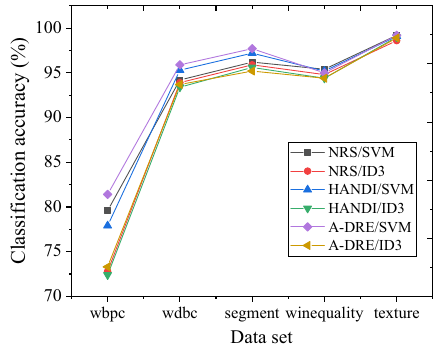
Figure 5. Classification accuracy of different data reduction algorithms.